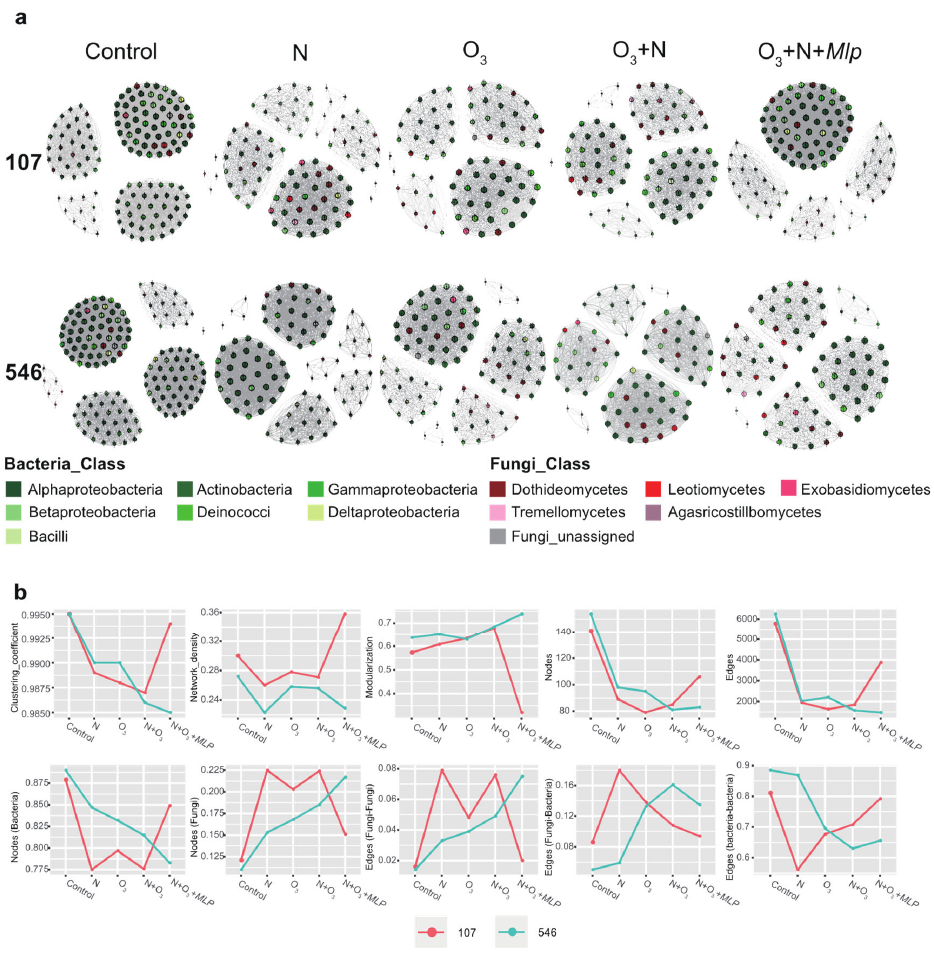
Figure 6. The co ‐ occurrence networks ( a ) and trends of microbial network association indices ( b ) of phyllosphere microbiome for two hybrid poplars (‘107’ and ‘546’) in five conditions. No ( a ) biotic stresses (control), N addition (N), elevated O 3 (O 3 ), N addition with elevated O 3 (N + O 3 ), N addition, elevated O 3 with Melampsora ‐ larici populina infection (N + O 3 + Mlp ).